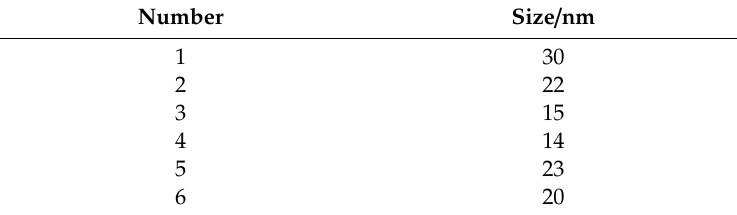
Table 1. Diameter of c-MWCNTs in drug-loaded MPEG-PDLLA / c-MWCNT nanocomposites prepared with a mass ratio of c-MWCNTs / MPEG-PDLLA of 0.1:1 (tube diameter < 8 nm, length 0.5~2 µ m).